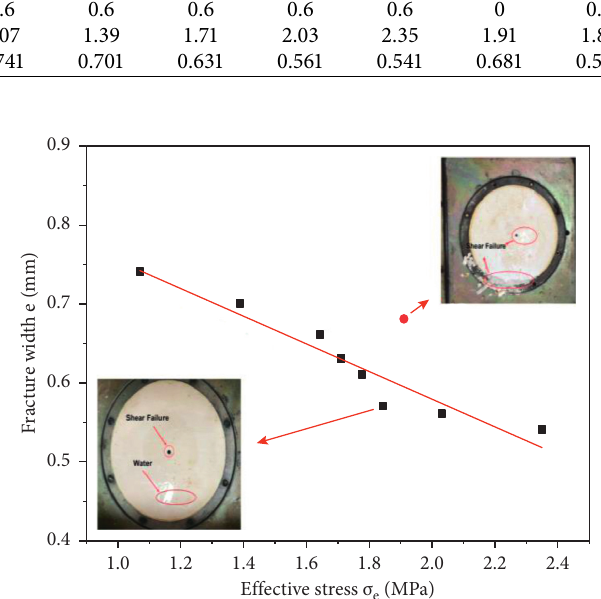
Figure 7: Fitting curve of relationship between fracture aperture and effective